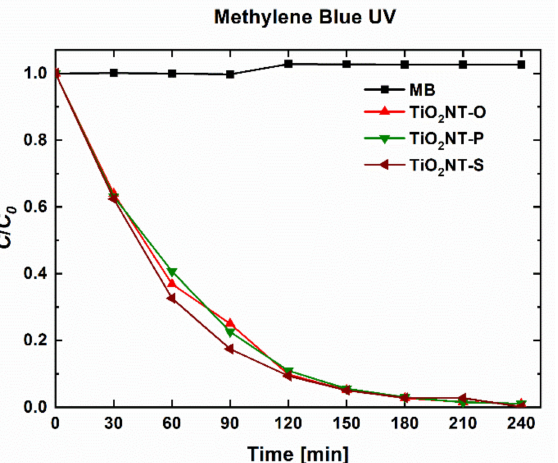
Figure 6. Degradation efficiency of nanotube arrays towards Methylene Blue (MB) after irradiation with UVA